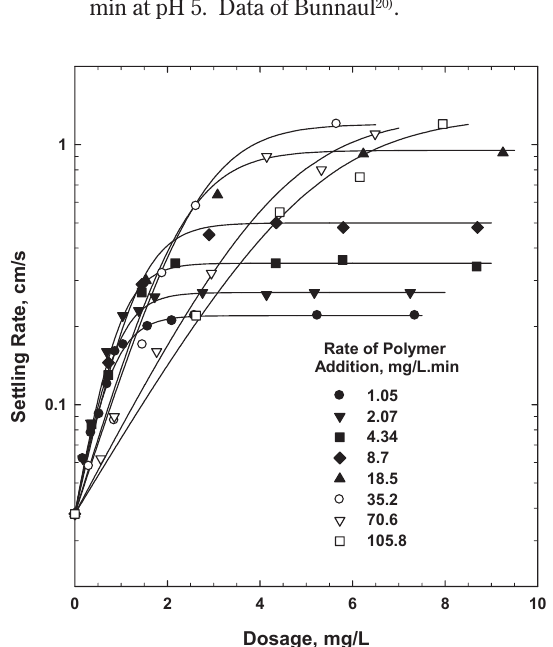
Fig. 7 Effect of the rate of continuous (nonionic) poly- mer addition on floc growth in 3% by weight ka- olin suspensions. Data of Ray 19, 21)